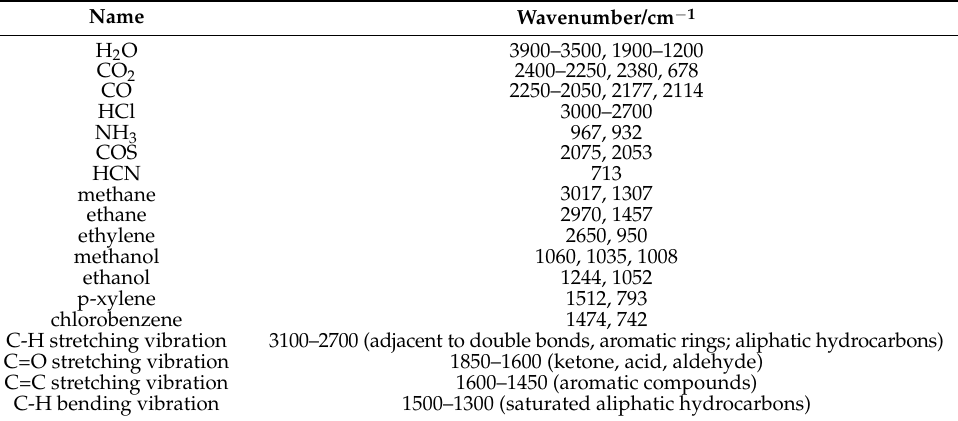
Table 3. FTIR characteristic absorption bands (peaks) of some gaseous compounds and